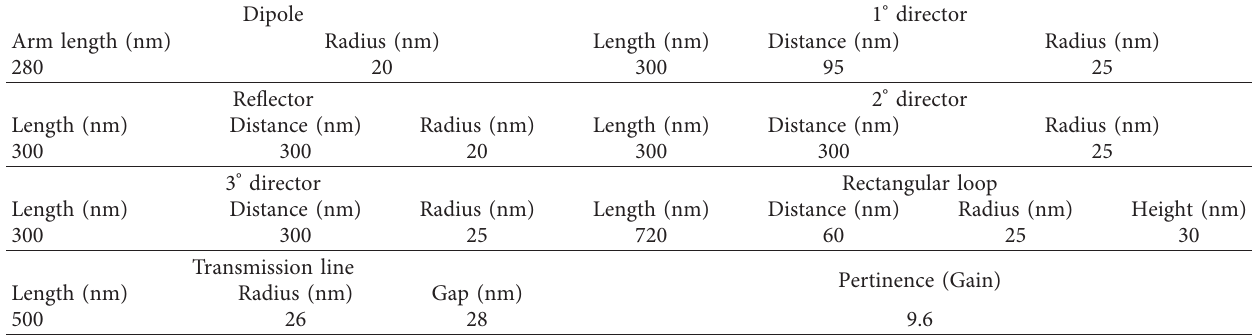
Table 6: Optimal dimensions found by the fuzzy adaptive AGPSO method for YU nanoantenna connected to a transmission line and combined with a rectangular